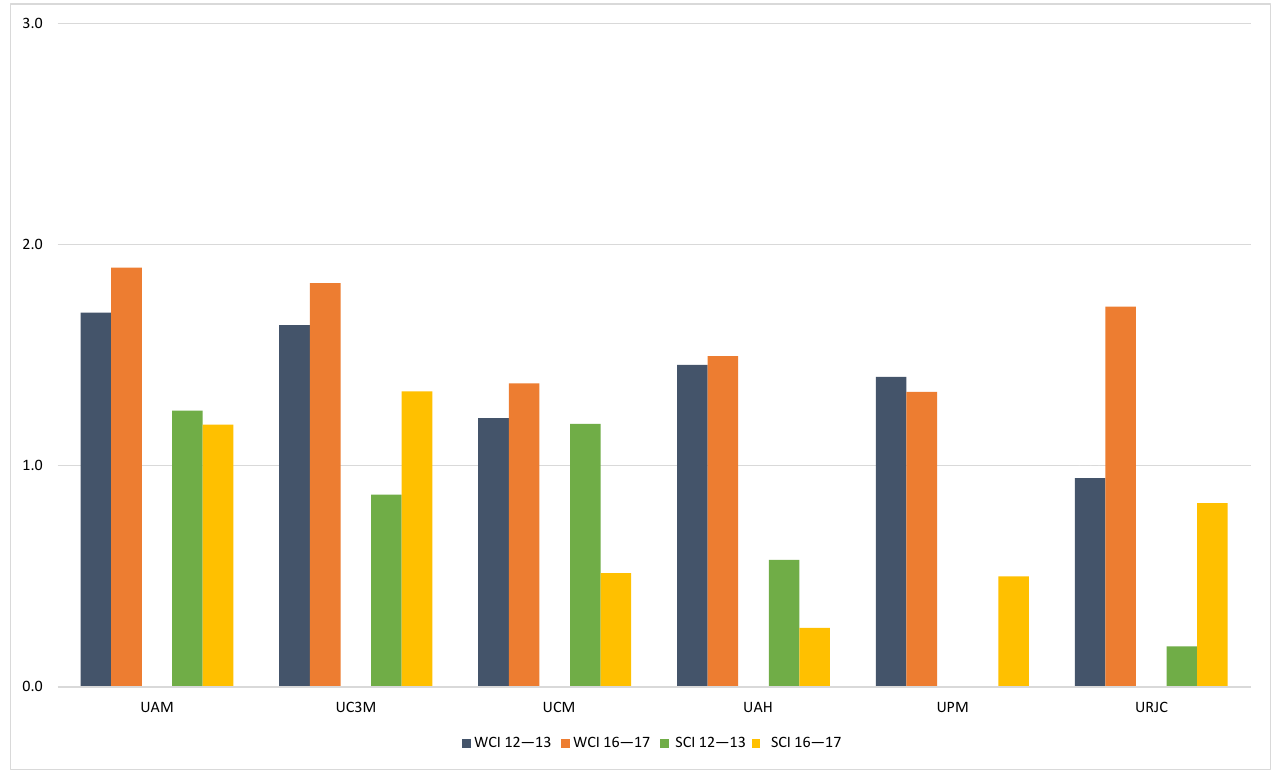
Figure 4. Evolution in the teaching mission of the Catalan public university system from 2012–2013 to 2016–2017.